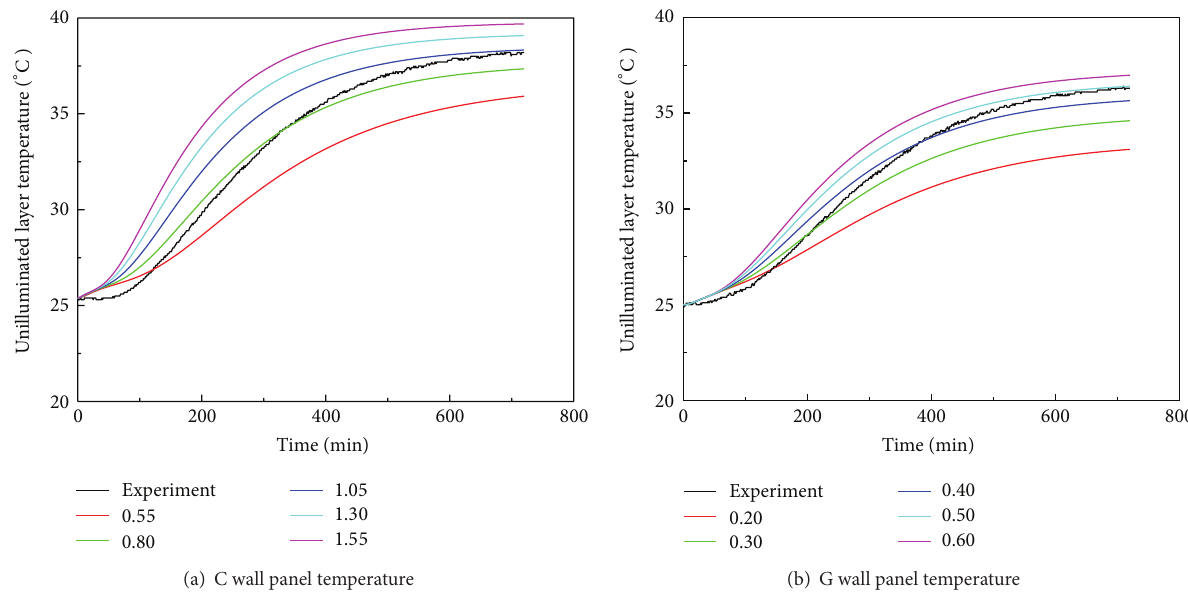
Figure 6: (a) Various 𝑇 - 𝑡 curves of unilluminated layer in C wall panel are generated by varying the thermal conductivity of concrete. The black line refers to the recorded temperature in the C specimen during experiment, while the colored lines are predicted temperature variation corresponding to different thermal conductivities of concrete; (b) various 𝑇 - 𝑡 curves of unilluminated layer in G wall panel are generated by varying the thermal conductivity of gypsum. It is noted that the colored lines are predicted temperature variation corresponding to different thermal conductivities of gypsum.